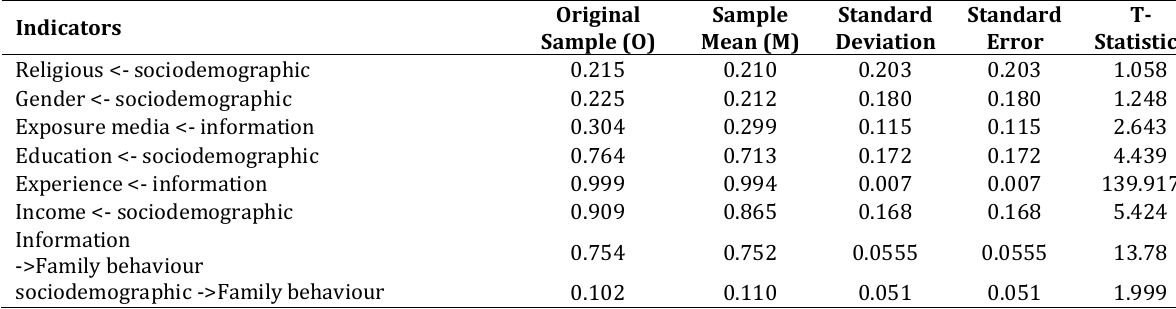
Table 3. Path Coefficients: effect of sociodemographic and information on family